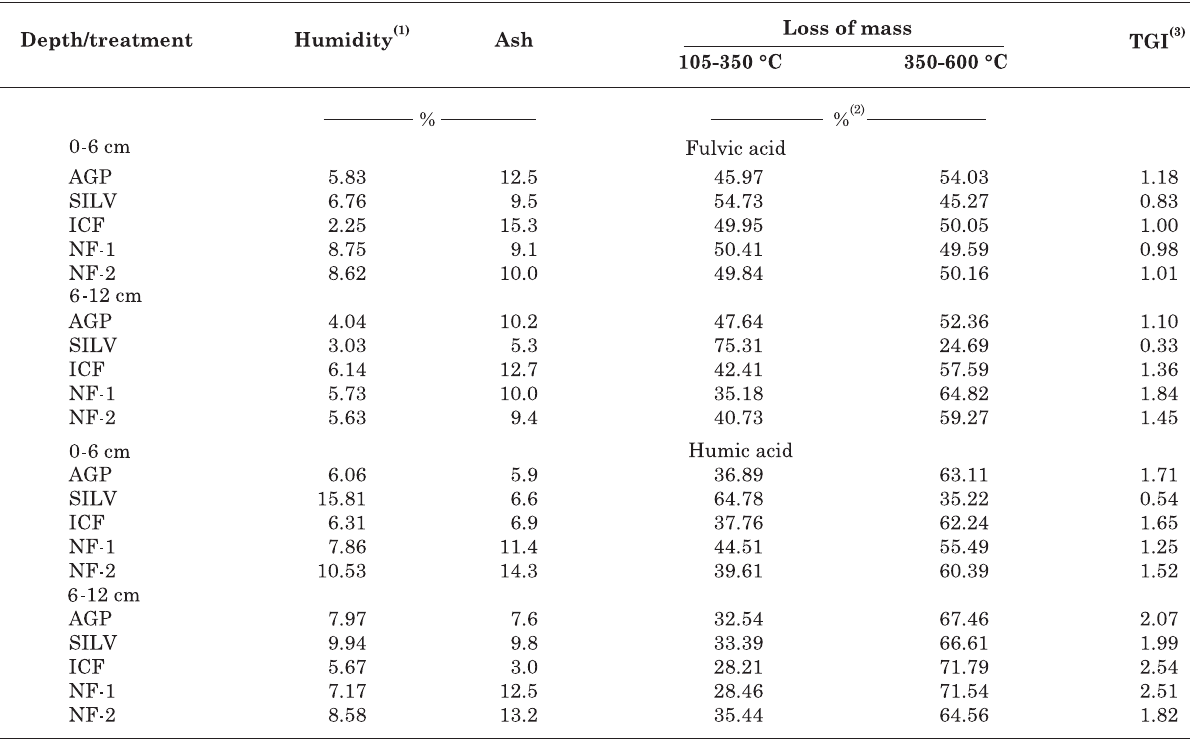
Table 4. Thermogravimetry: humidity, ash content, weight loss, and thermogravimetry index (TGI) in function of different ranges of temperature of solid-state humic and fulvic acids extracted from the 0– 6 and 6–12 cm layers of a Chromic Luvisol under agroforestry, intensive cultivation, and native